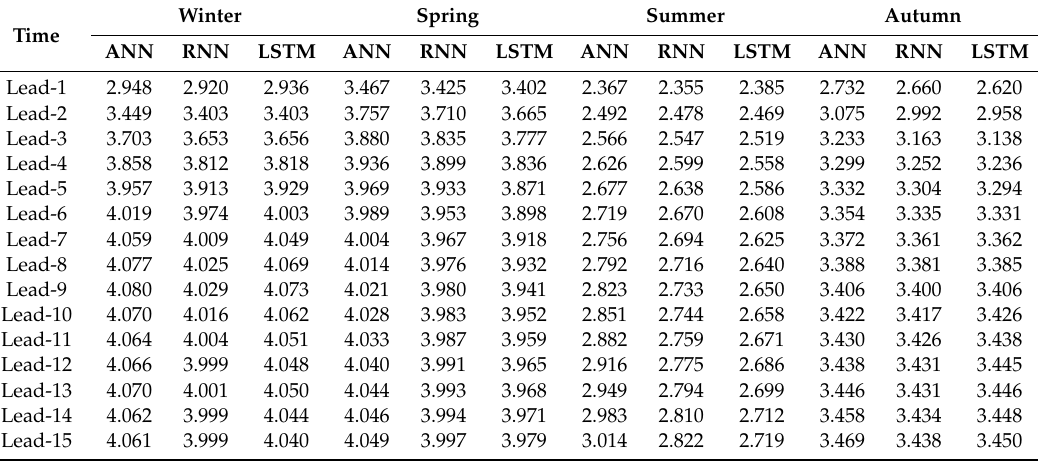
Table 6. Root mean square error (RMSE; °C) of test data of daily maximum temperature for predicting the next 15 days.